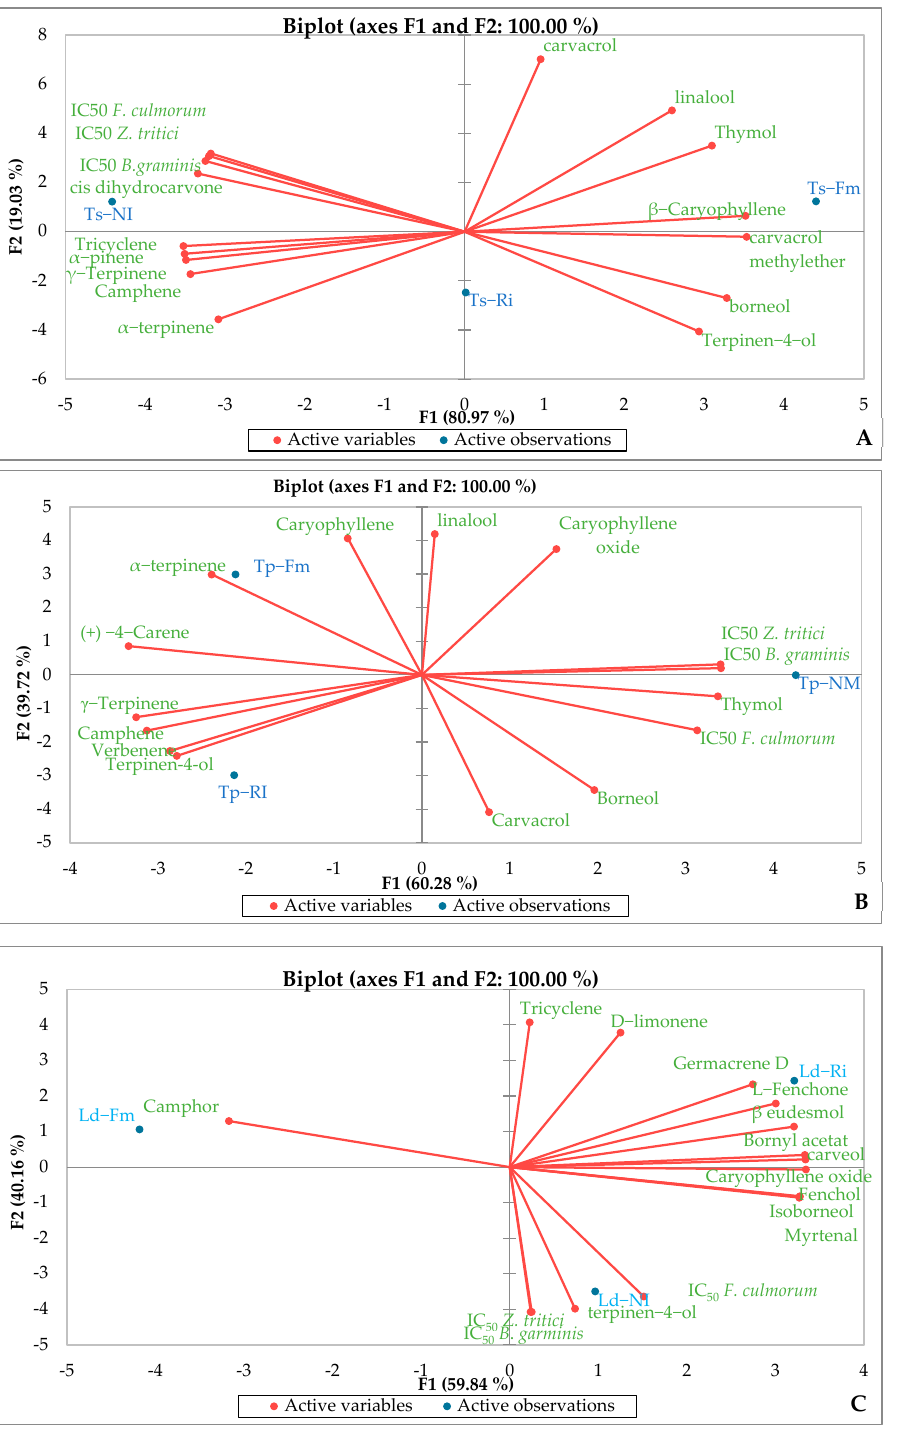
Figure 13. Correlation circles from the principal component statistical analyses (PCA) on antifungal activity and different chemical compounds in the essential oils of Thymus satureioides (Ts) ( A ), Thymus pallidus (Tp) ( B ), and Lavandula dentata (Ld) ( C ), non-inoculated (NI) or inoculated with Rhizophagus irregularis , (Ri) or Funneliformis mosseae .